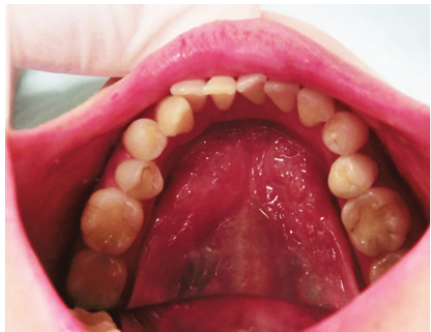
Figure 5: Ranula in the healed state following two treatments of local injection of